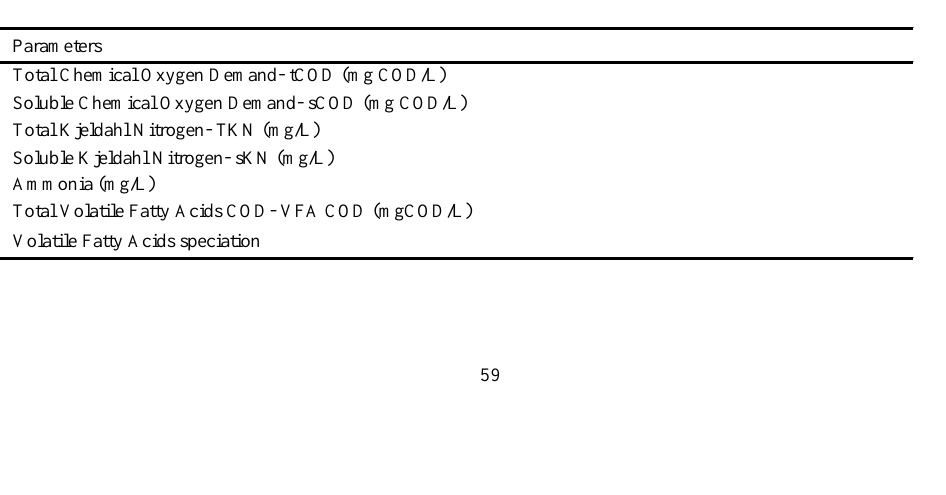
Table 1: The studied monitored